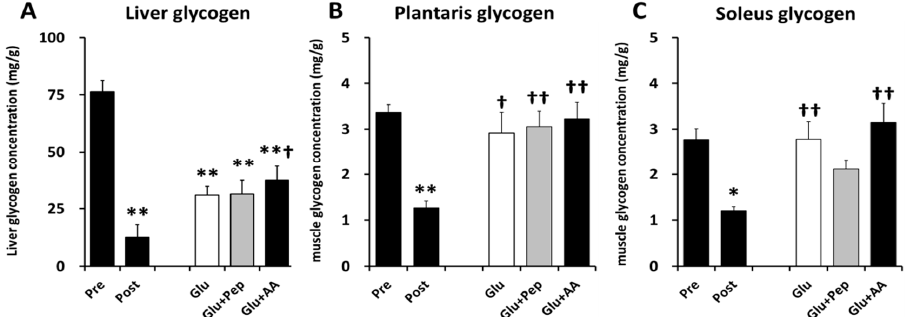
Figure 4. Glycogen content in the liver and muscles. ( A ) Liver glycogen concentration; ( B ) Plantaris muscle glycogen concentration; ( C ) Soleus muscle glycogen concentration. Values are presented as mean ± SEM. * significantly different from the pre-exercise (Pre) group ( p < 0.05); ** significantly different from the Pre-group ( p < 0.01); † significantly different from the post-exercise (Post) group ( p < 0.05); †† significantly different from the Post group ( p <